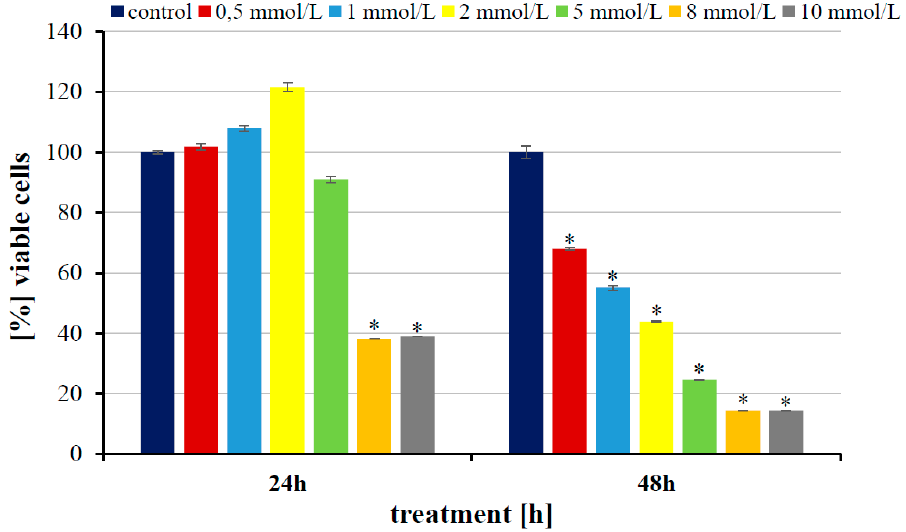
Figure 1. The viability of glioblastoma T98G cell line untreated and treated with 0.5, 1, 2, 5, 8, and 10 mmol/dm 3 of p-coumaric acid for 24 and 48 h. The results represent mean values from three independent experiments ± SD. Significant changes are expressed relative to controls and marked with asterisks. Statistical significance was considered if * p < 0.05.